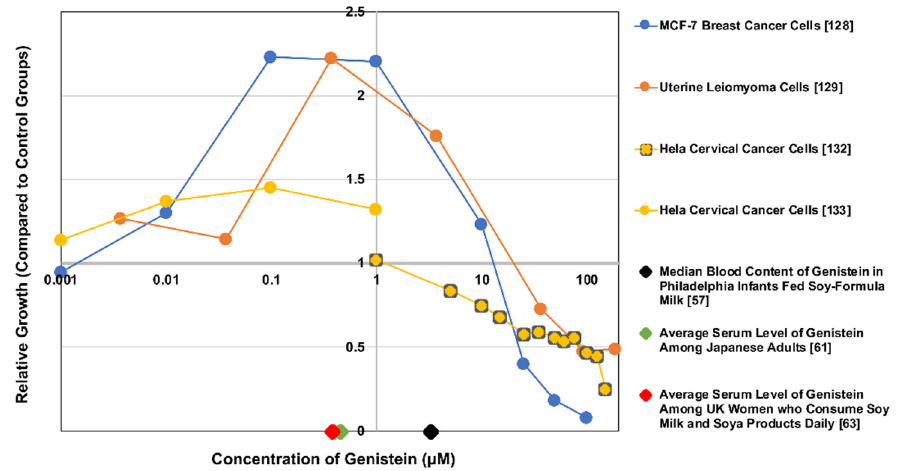
Figure 3. Relative growth of several cell lines at variable concentrations of genistein overlaid with serum levels of genistein for three populations. Data from [57,61,63,128,129,132,133]. Note that no (0) genistein marks a value of 1 relative growth unit. This is considered the control group for all studies. Also, note that none of the cell lines were reported to be prominent metabolizers of genistein. Concurrently, the serum concentration studies only assessed circulating genistein, while its metabolites (likely the most predominant forms in vivo) would presumably also have effects on the cell lines.